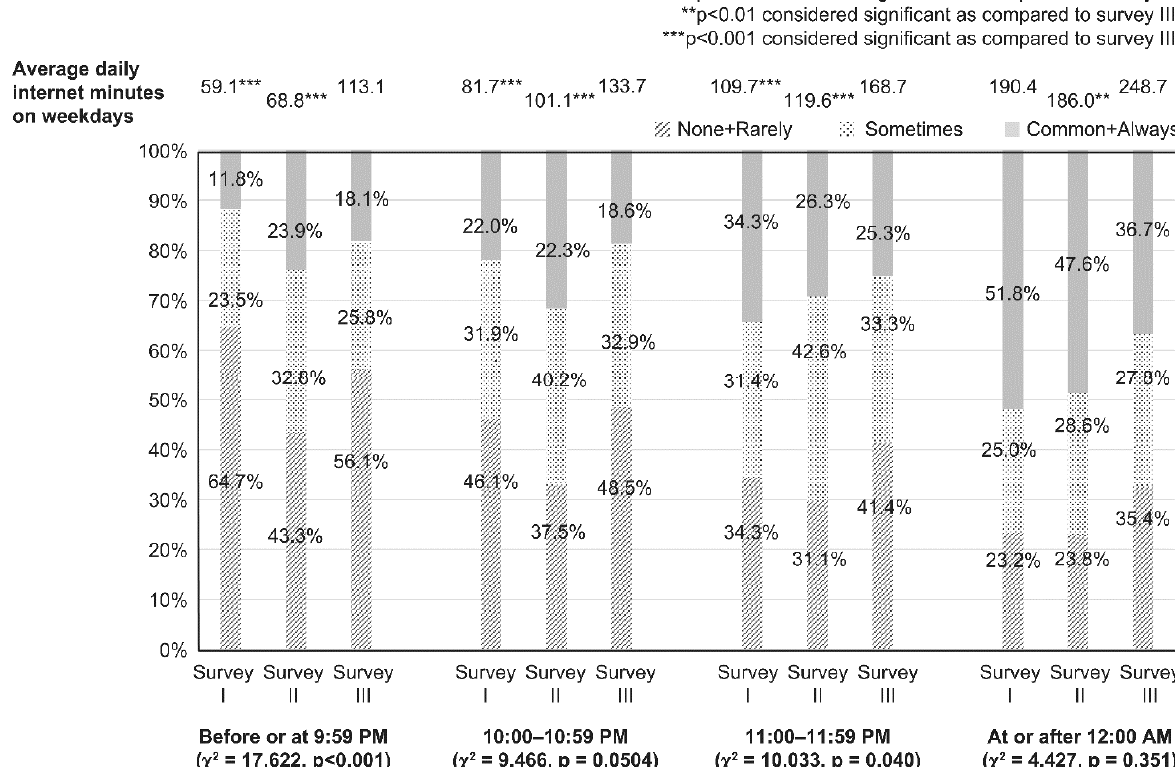
Figure 2. Average daily Internet minutes on holidays by bedtime on holidays in each survey. A comparison of the duration of internet use (in minutes) on holidays among groups as per bedtime was performed using ANOVA. A post hoc analysis between the group with bedtime before or at 9:59 PM and groups with bedtime at or after 10:00 PM (10:00–10:59 PM, 11:00–11:59 PM and at or after 12:00 PM) was performed using Dunnett’s test.